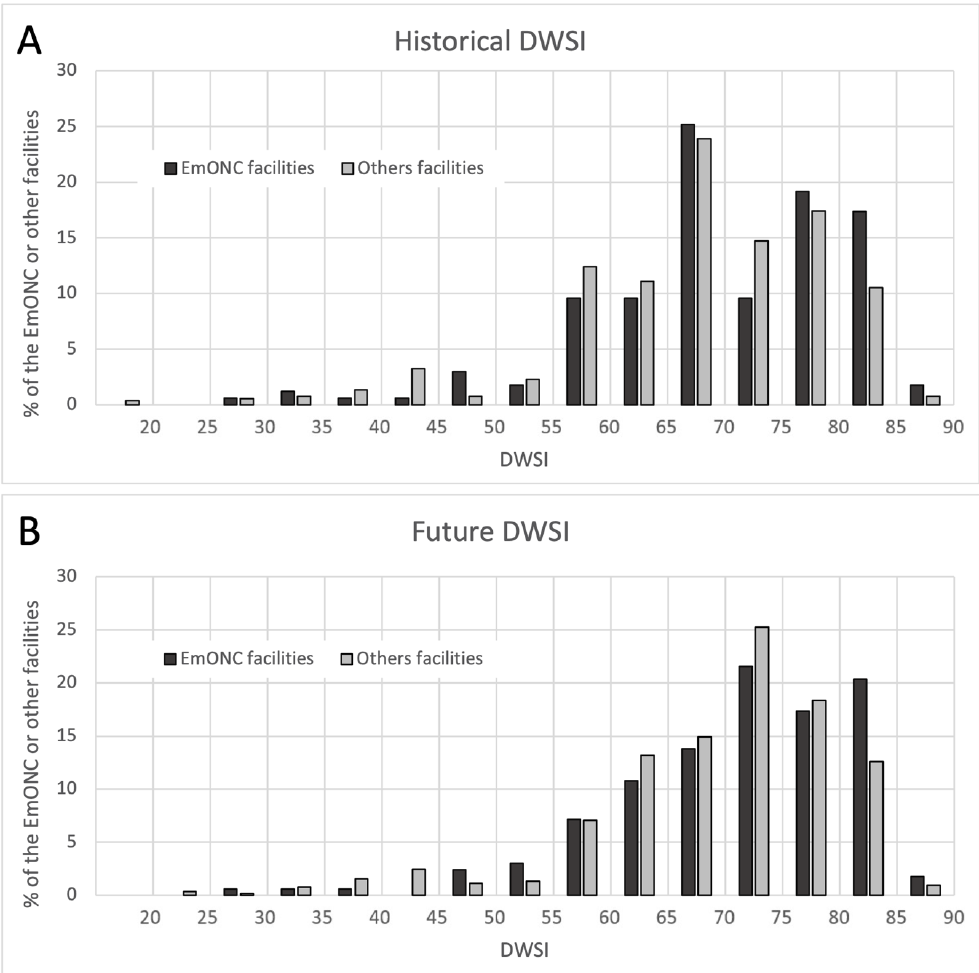
Figure 7. Distribution of DWSI values among EmONC facilities and other facilities, for the historical ( A ) and future ( B ) period.